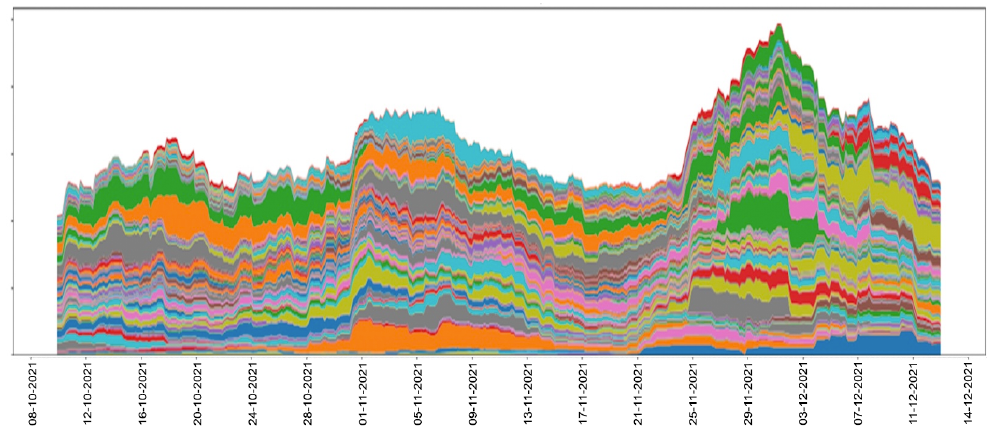
Figure 4. Stacked line chart of cumulative periodicity intensity from all 169 student participants. y -axis values have been normalised to the range 0 to